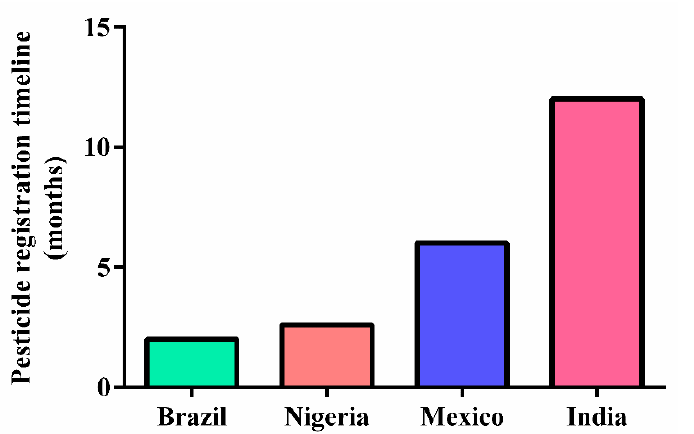
Figure 5. Pesticide registration timeline in different countries, according to World Health Organi- zation.